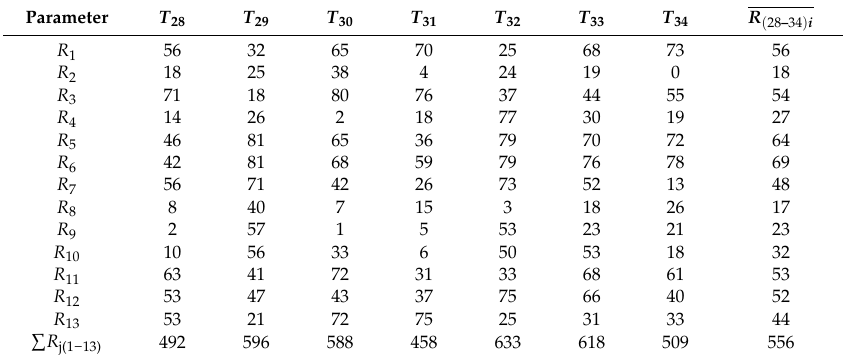
Table A19. Ranking of T j territories on land activity, Southern Federal District. Parameter